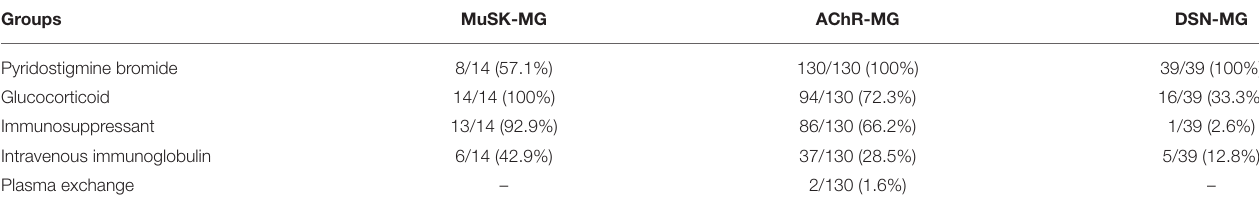
TABLE 4 | Therapeutic strategy among the three groups.